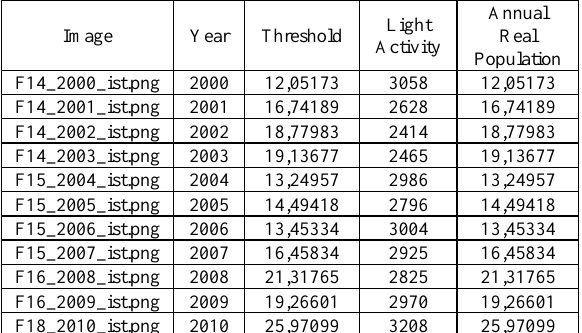
Figure 1. The cropped images in 2013 a) Turkey b) Ankara c)